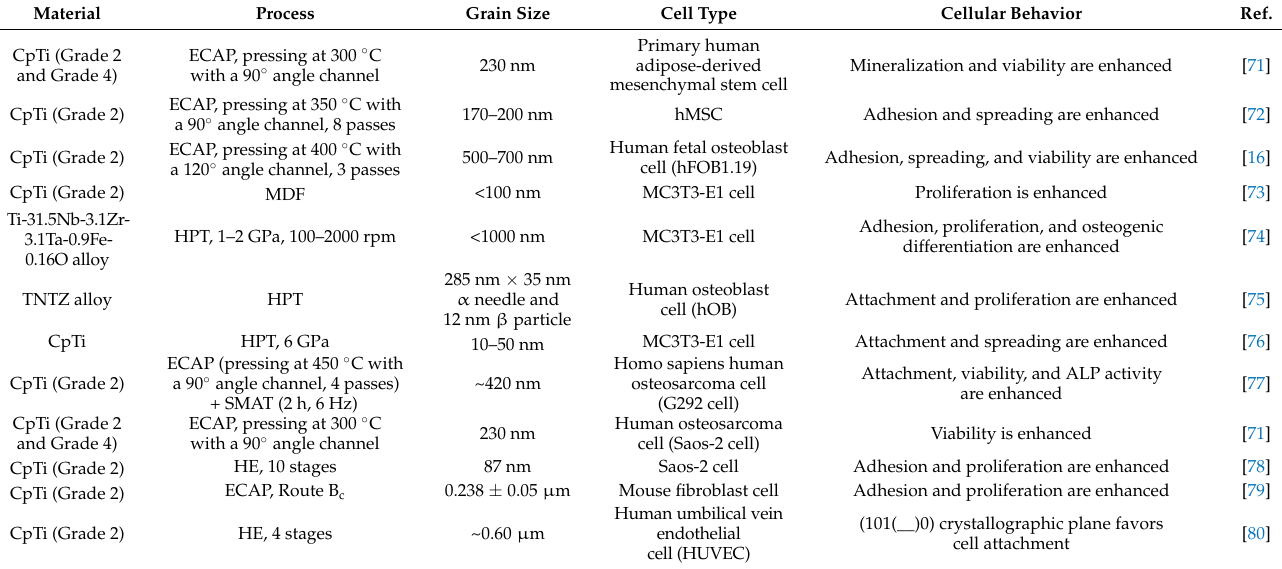
Table 2. Cell response to titanium and its alloys after bulk grain